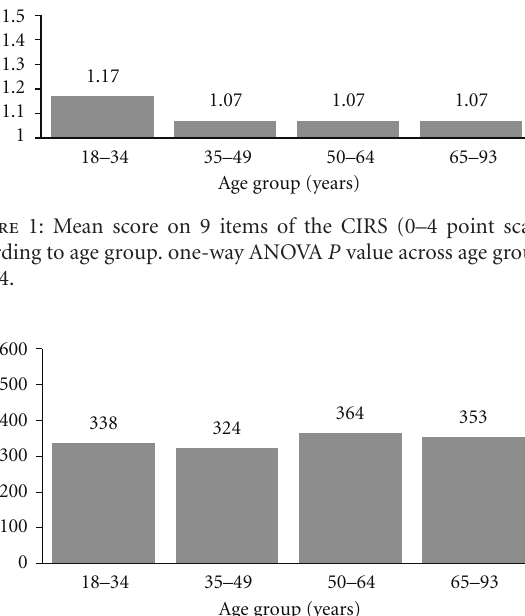
Table 2: Characteristics of participants ( n = 2,440).